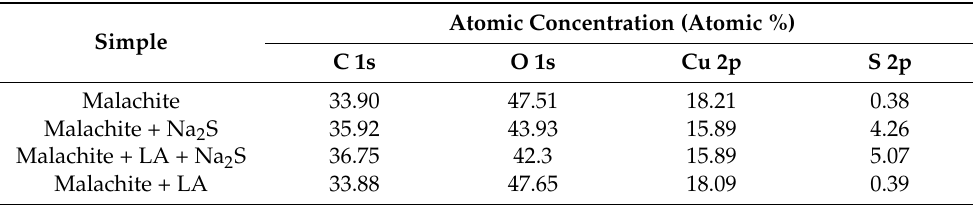
Table 2. Relative contents of representative elemental constituents of malachite surface.